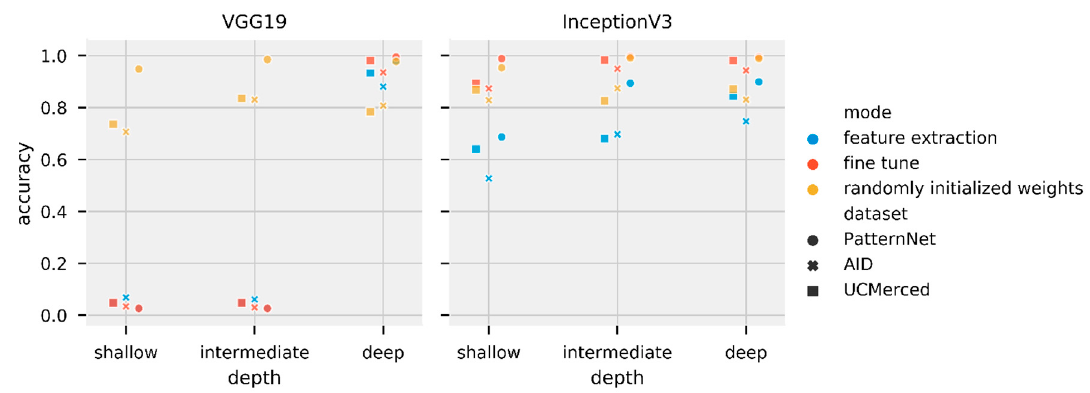
Figure 8. Test set accuracy for all VGG19 and Inception V3 versions trained with all datasets using SGD (1e-3) momentum 0.9. Left panel shows VGG 19 results, right panel shows Inception V3 results. Note VGG19 shallow and intermediate feature extraction and fine-tune versions were trapped in local minima. Some of the points in local minima appear wine-colored as the blue (feature extraction) points and red (fine tune) points are very closed and partially overlaying each other. Table 8. Best test set accuracy for Inception V3 and VGG19 version for each Dataset using SGD (1e-3) momentum 0.9 optimizer to perform transfer learning on models initially trained on PatternNet. Dataset Model Depth Mode Accuracy InceptionV3 Deep fine tune 0.838 AID VGG19 intermediate fine tune 0.833 InceptionV3 intermediate 0.948 UCMerced VGG19 Deep fine tune 0.886